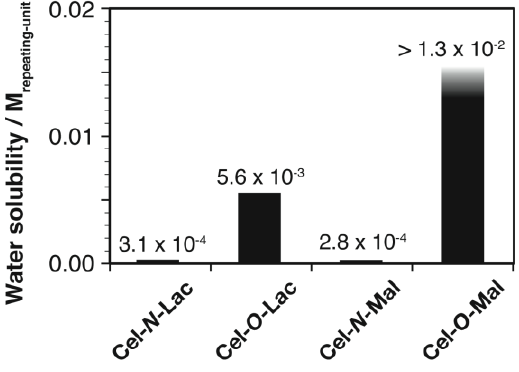
Figure 5. Water solubility of the cellulose-based glycoclusters: water solubility of Cel- O -Mal is too high to be